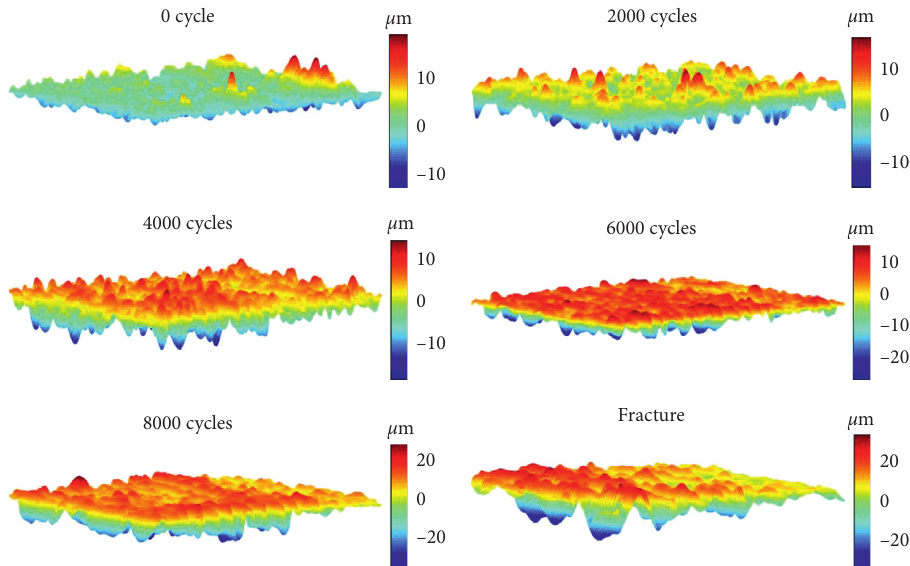
Figure 5: 3D surface topography of the specimen during fatigue.